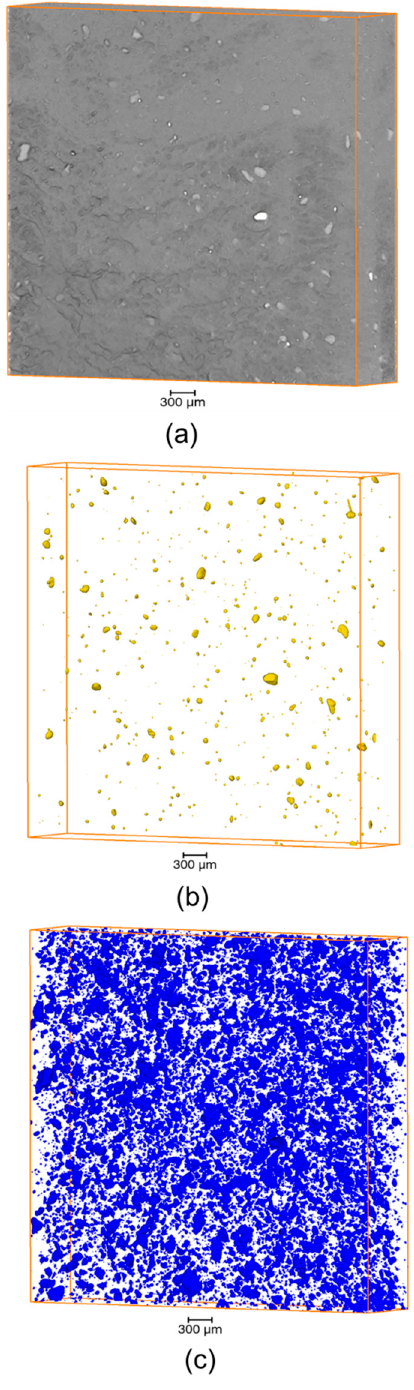
Figure 8. Volume rendering (5 mm × 5 mm × 1 mm) obtained by µ CT of ETFE/AP/MK (60/20/20): ( a ) overall composite visualization; ( b ) AP object visualization; ( c ) MK object visualization. AP was synthesized at 270 °C.